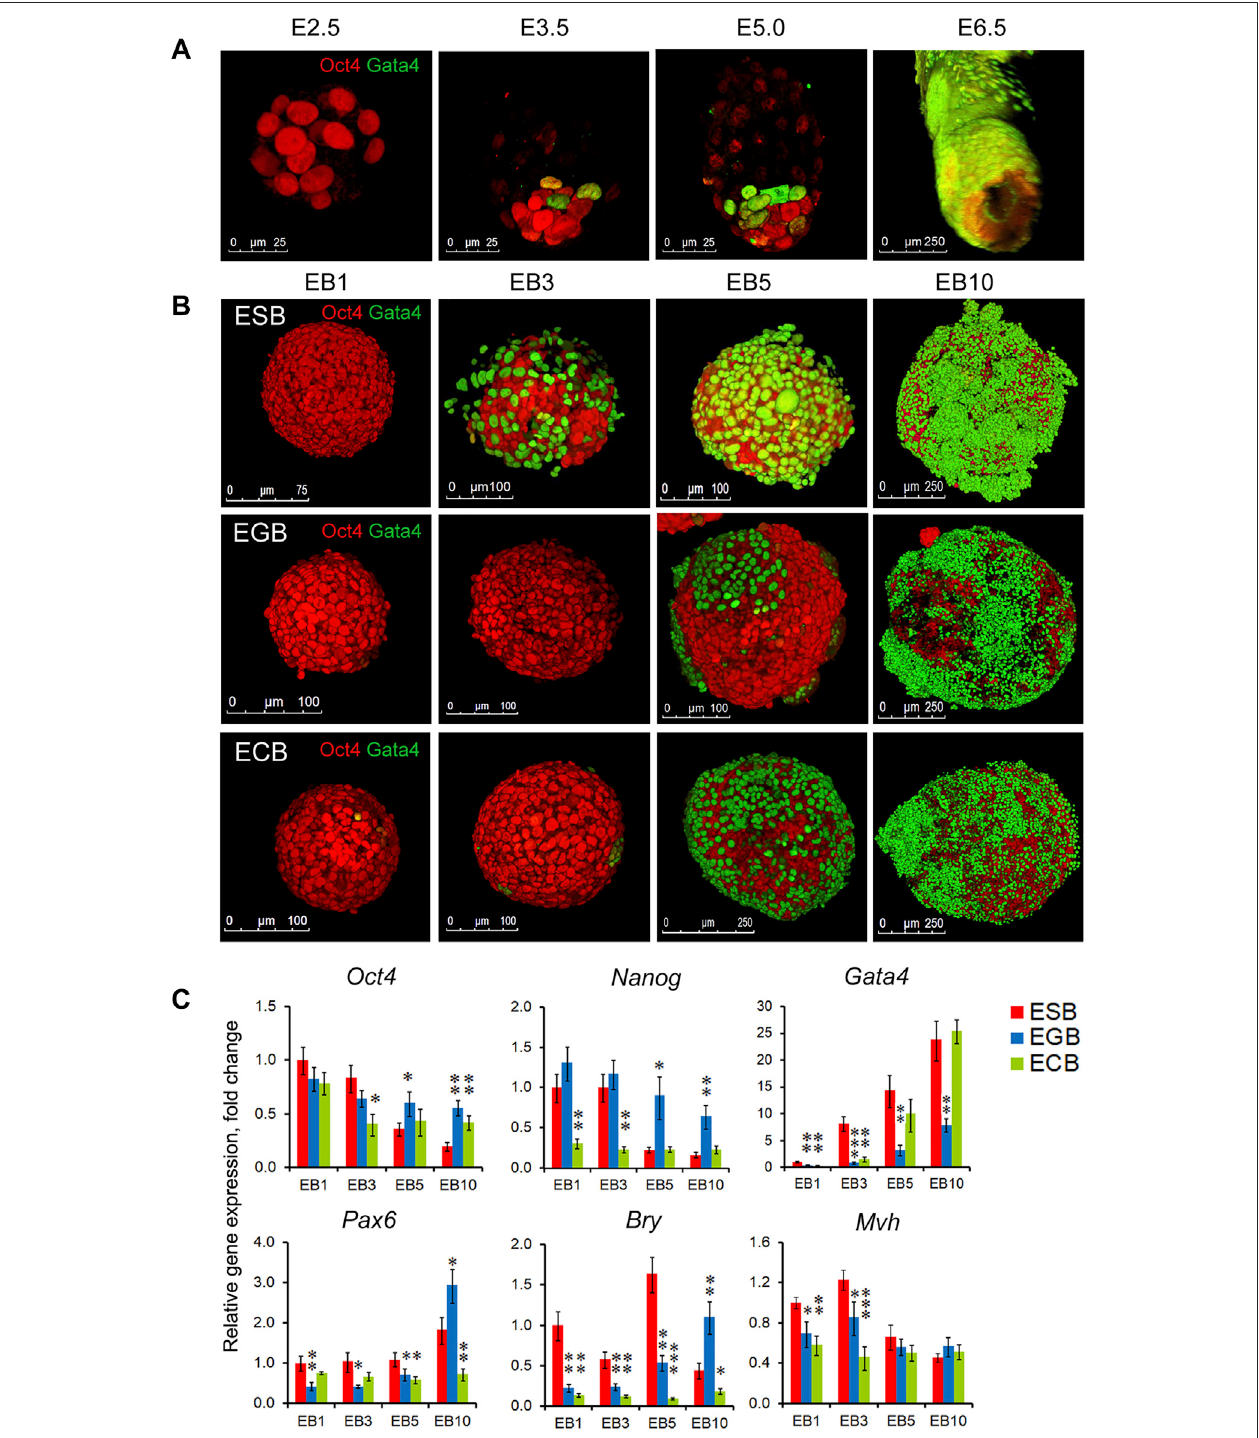
FIGURE 3 | Spatiotemporal differentiation dynamics of ESB, EGBs, ECBs, and early embryos. (A) 3D reconstructed models of spatiotemporal patterns of the pluripotent (Oct4) and ExEn (Gata4) cells in mouse embryos at the E2.5, E3.5, E5.0, and E6.0 stages. Confocal z-stack images were processed using ImageJ/Fiji 3D Viewertool. (B) 3DreconstructedmodelsofspatiotemporalpatternsoftheEpi-l(Oct4)andExEn(Gata4)cellsinESB,EGBs,andECBsattheEB1,EB3,EB5,andEB10 stages. (C) Expression pro fi les of embryonic lineage markers in differentiating EBs: pluripotent - Oct4 and Nanog , ExEn — Gata4 , neuroectodermal — Pax6 , mesodermal — Bry ,germline — Mvh .Relative geneexpressionforeach markerwasevaluatedrelative toexpression levelsinESB1.Dataareshown asmeans ±s.d.from three experiments. * p < 0.05 , ** p < 0.01 , *** p < 0.001 , ANOVA.